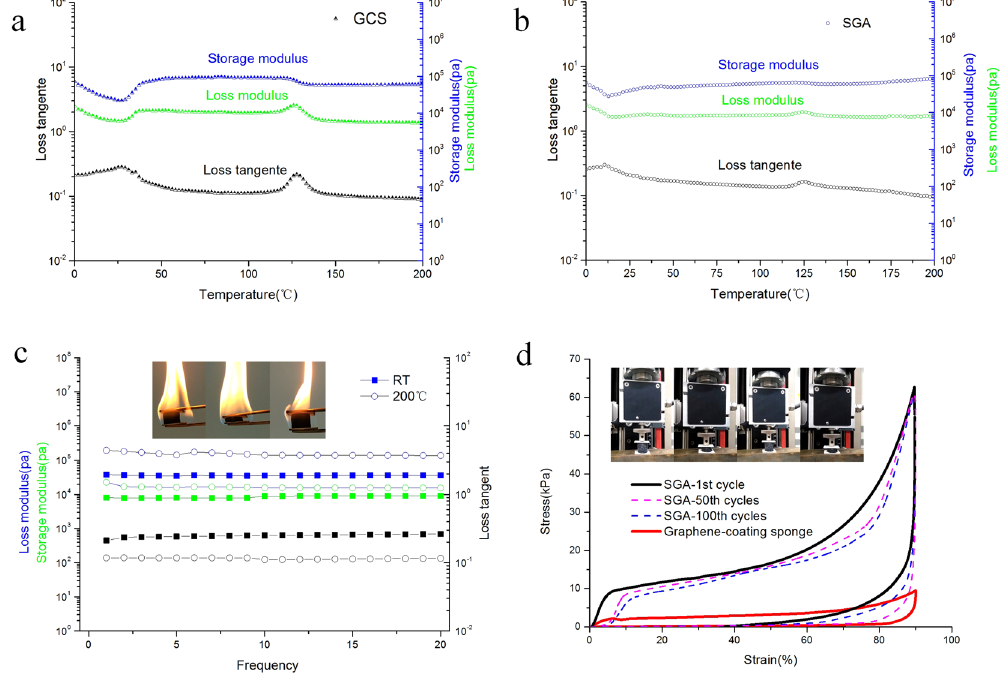
Figure 3. Storage modulus (E’), loss modulus (E”), and tan δ (the ratio of E’/E”) as a function of temperature for ( a ) GCS and ( b ) SGA. ( c ) Storage modulus (blue), loss modulus (black) and damping ratio (green) of the SGA is shown as a function of compression frequency at 0–200 °C; The inset images show a burning SGA sample (up to 350 °C) with its typical resilience. ( d ) The compressibility of SGA.